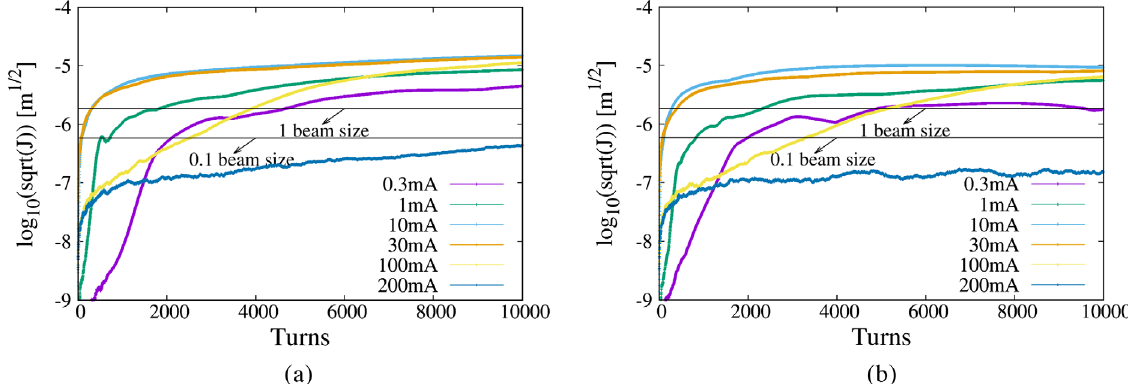
FIG. 2. The maximum bunch action as a function of the tracking turns in the weak-strong simulation without (left) and with (right) synchrotron radiation damping and quantum excitation. In each subfigure, there are six curves related to beam current settings 0.3, 1, 10, 30, 100, and 200 mA. The synchrotron radiation damping is not able to mitigate the beam-ion